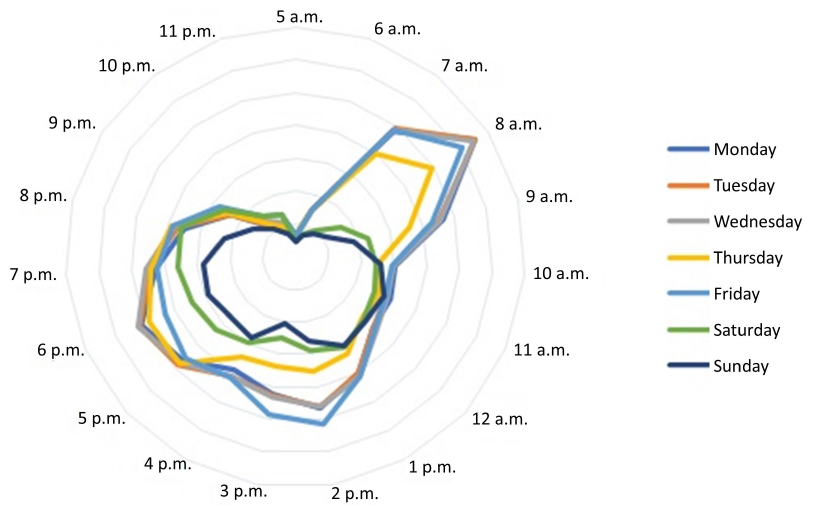
Figure 5. Total number of passenger per day and